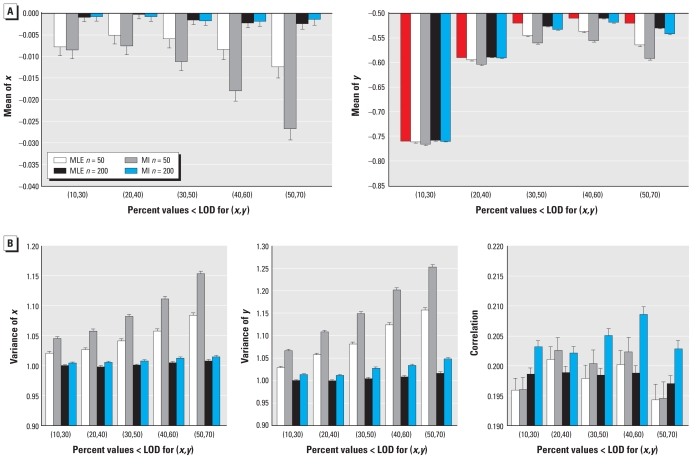
(A) MLEs and MI estimates for μx (left) and μy (right) from 5,000 simulated samples. The true value for μx is 0; the true values for μy are −0.76, −0.59, −0.52, −0.51, and −0.52 for (10, 30), (20, 40), (30, 50), (40, 60), and (50, 70) percent of (X, Y) < LOD, respectively. The true value of μy is represented by the red reference bars. (B) MLEs and MI estimates for σ2x (left), σ2y (middle), and ρ (right) from 5,000 simulated samples. The true values for σ2x, σ2y, and ρ are 1, 1, and 0.2, respectively.